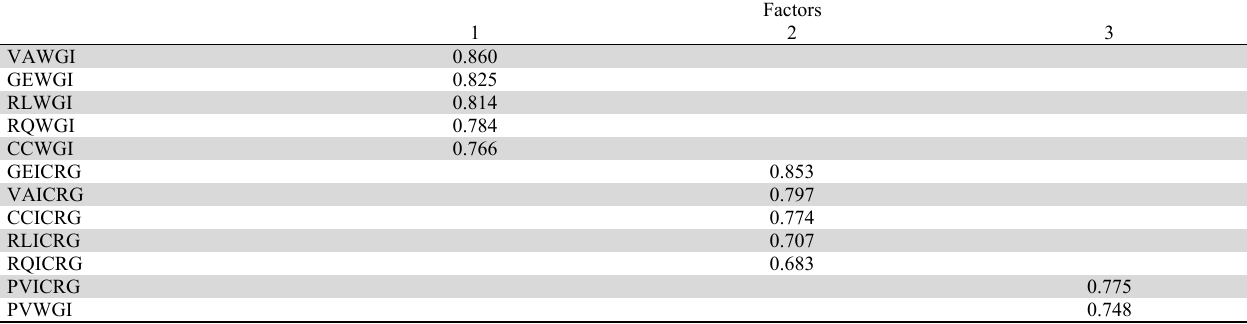
Rotated Component Matrix